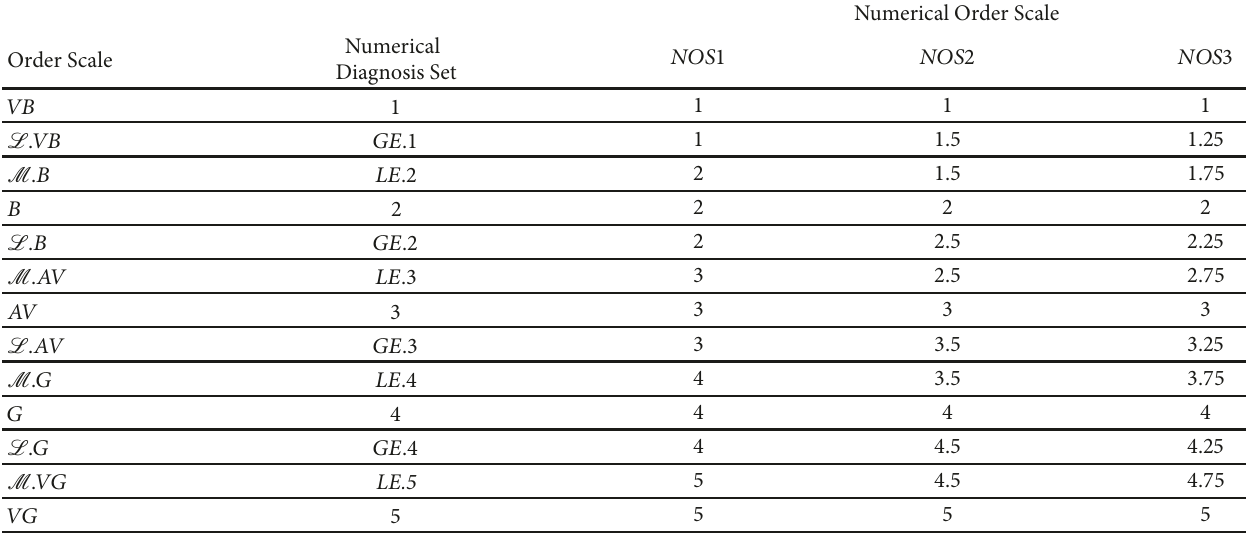
Table 5: The mechanisms of transforming an order scale into a numerical order